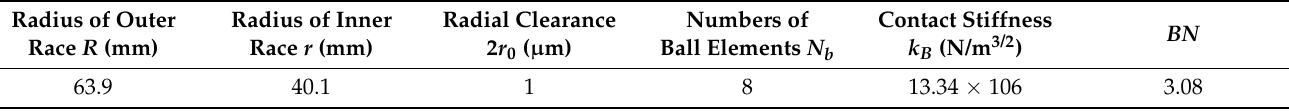
Table 2. The structural parameters of the ball bearing.